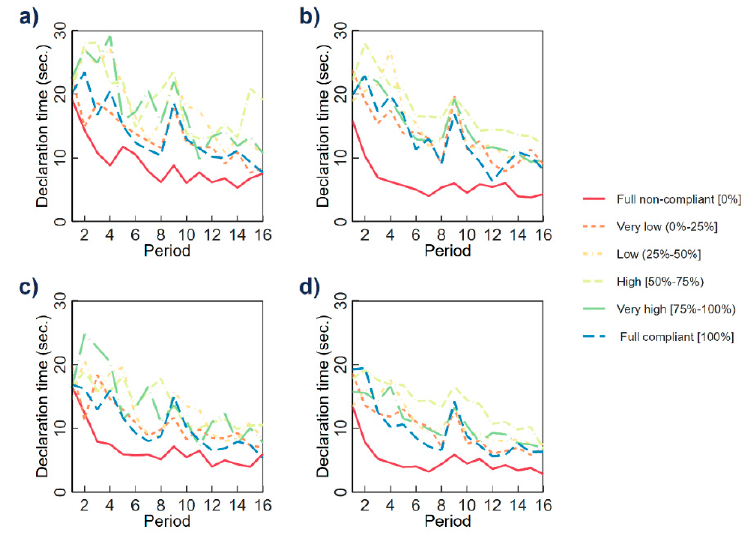
Figure 2. Declaration time and tax compliance level over time. ( a ) Average declaration time by tax compliance level of individual decisions; ( b ) Average declaration time by individuals grouped by their average tax compliance level; ( c ) Median declaration time by tax compliance level of individual decisions; and, ( d ) Median declaration time by individuals grouped by their average tax compliance level.